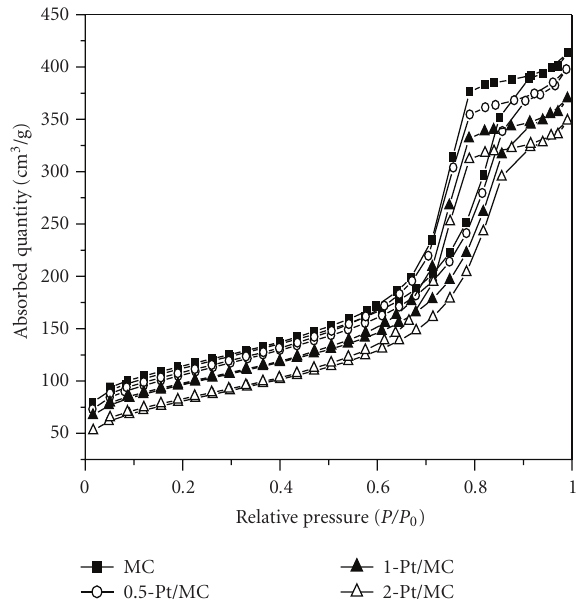
Figure 1: The N 2 adsorption-desorption isotherm of the as- prepared MC, 0.5-Pt/MC, 1-Pt/MC, and 2-Pt/MC